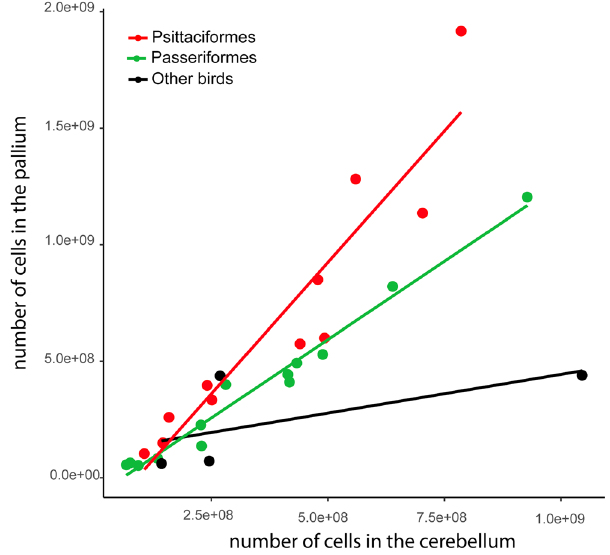
Figure 4. Scatterplot of the number of cells in the cerebellum of several species of birds versus the number of neurons in the pallium. Data from 36